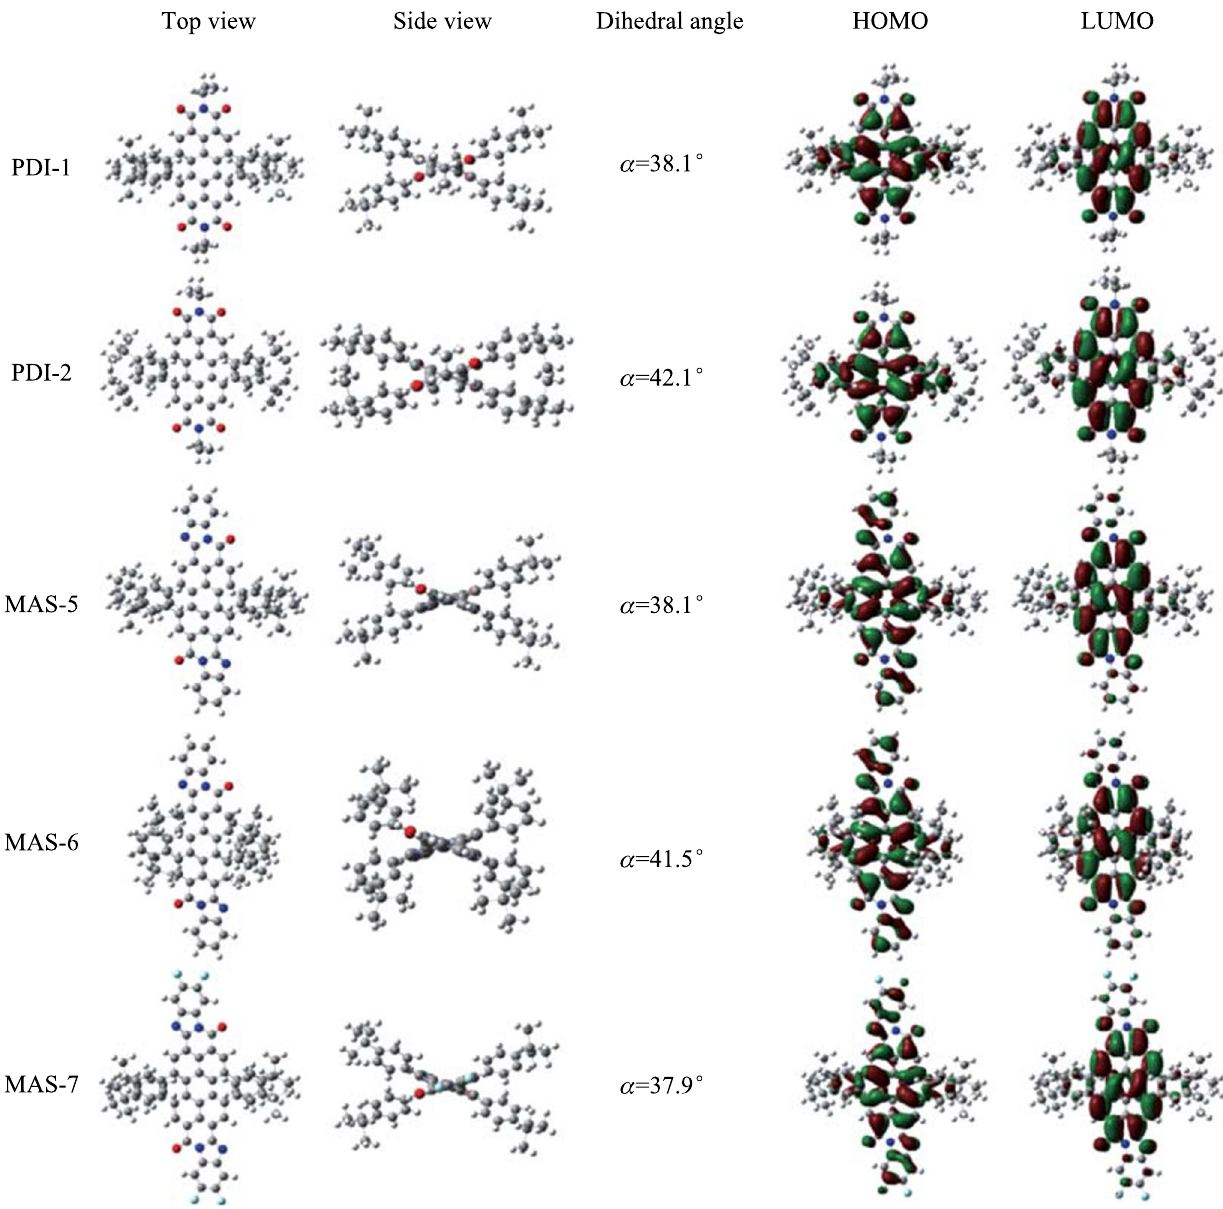
Fig. 3 Optimized molecular conformation and frontier orbital electron distribution of NFAs based on DFT